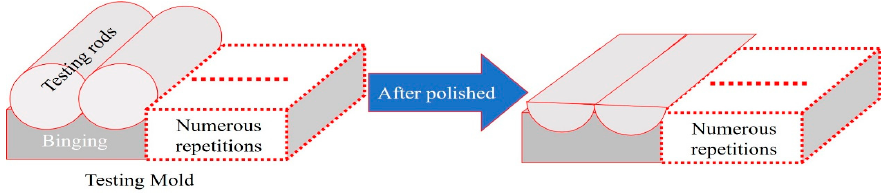
Figure 1. Schematic diagram of the X-ray diffraction (XRD) testing mold.